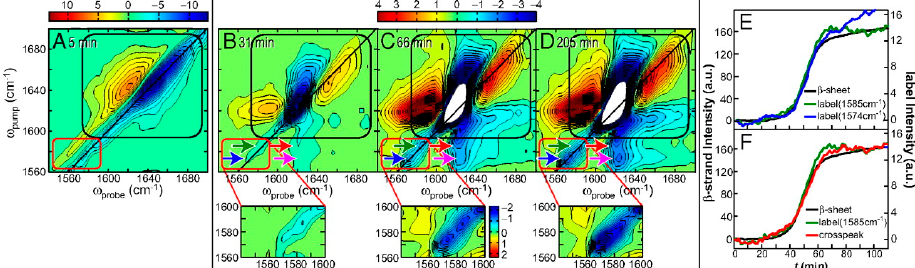
Figure 3. 2D-IR spectra and kinetics curves of human IAPP with 13 C= 18 O labeled at the Ala25 residue [113]. ( A ) The first 2D-IR spectrum at t = 5 min. ( B – D ) Difference 2D-IR spectra at t = 31, 66, and 205 min, calculated by subtracting the t = 5 min spectrum. Black boxes surround the spectral features of the unlabeled portion of the peptide, whereas red boxes enclose the diagonal peaks of the isotope labeled Ala25. Blue and green arrows highlight the 2 labeled features, whereas magenta and red arrows point to the cross-peak between the 13 C= 18 O Ala25 and the unlabeled β -sheet. ( E ) Kinetics of the diagonal peaks of the unlabeled β -sheet at 1617 cm − 1 and the 2 label features (blue and green arrows). ( F ) Comparison of the kinetics of the cross-peak and the diagonal peaks. Reprinted with permission.